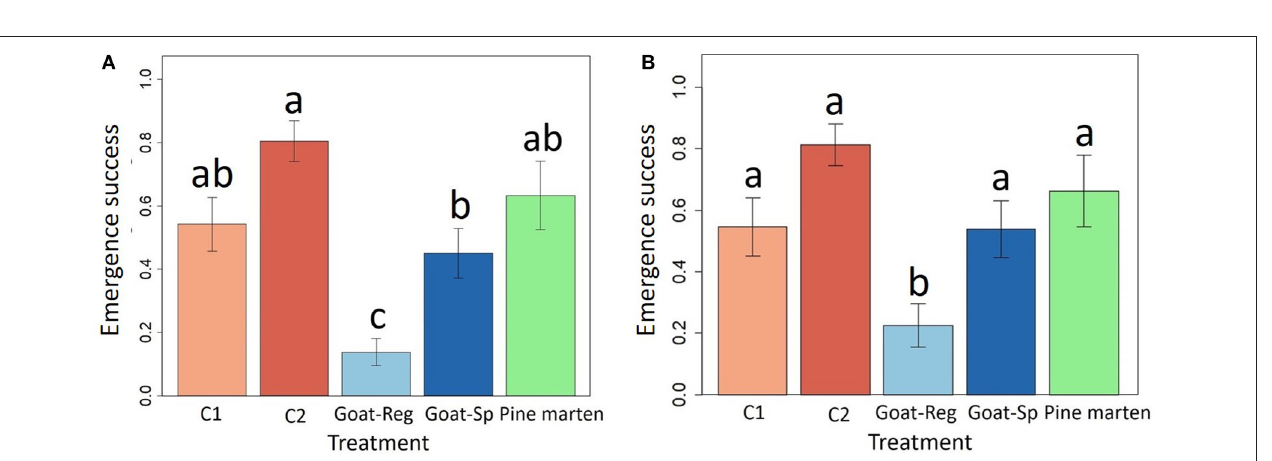
FIGURE 6 | Model-adjusted means ( ± SE) of the final emergence success, with (A) and without predated seeds by insects (B) , for the five treatments (C1 or “control seeds with pulp”, C2 or “manually - depulped control seeds”, Goat-Reg or seeds regurgitated by goat, Goat-Sp or seeds spit out by goat, and Pine marten or pine marten-ingested seeds). Different letters denote significant differences between paired levels in Tukey